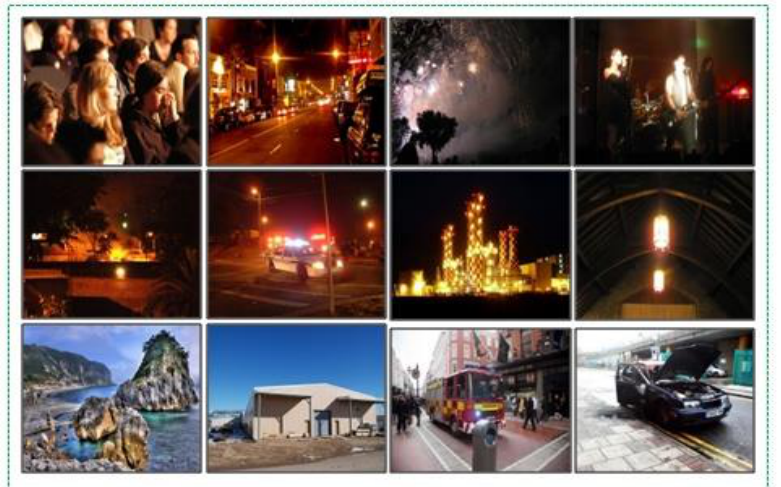
Figure 5. Fire-like lights.